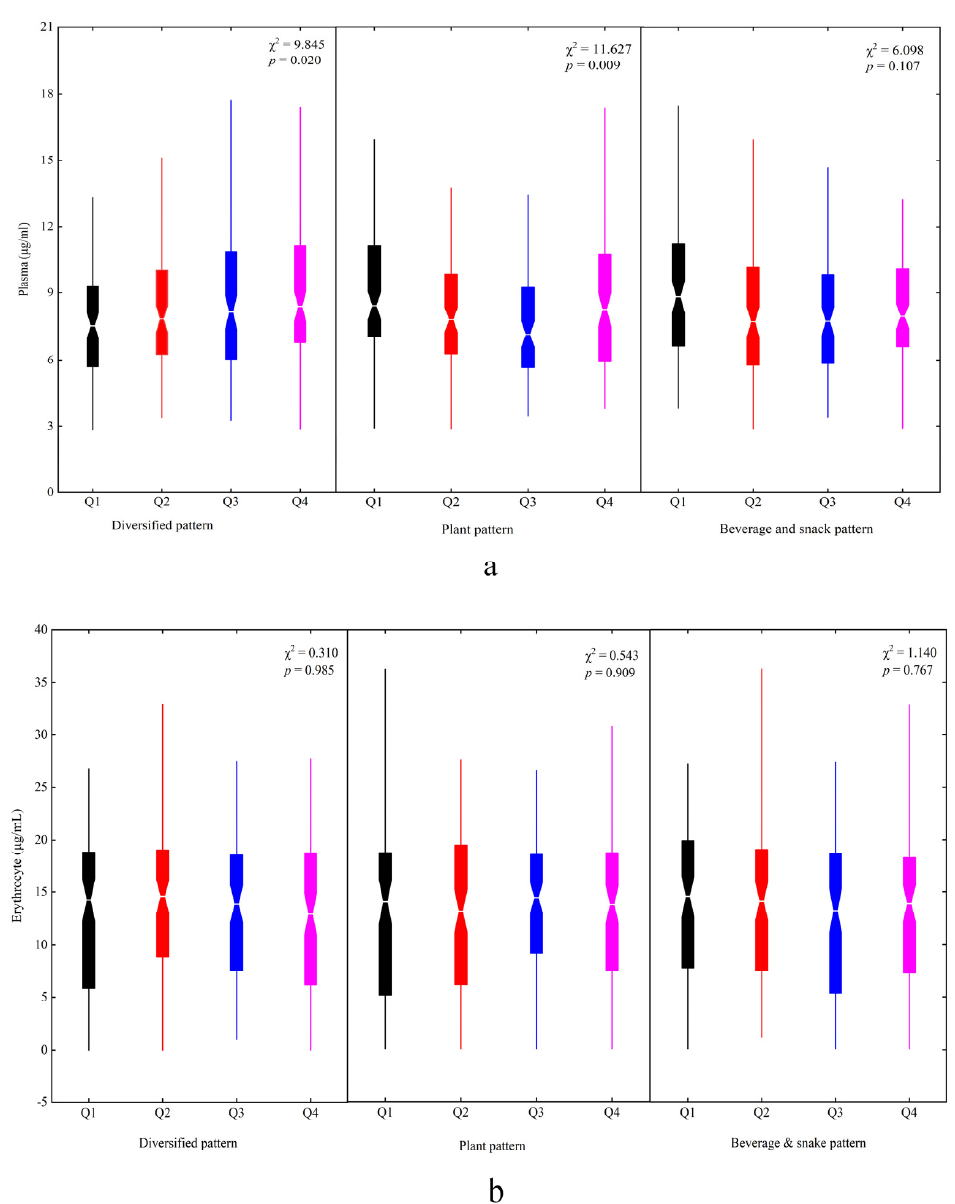
Figure 3. The plasma and erythrocyte DHA status in different dietary patterns among children: ( a ) plasma and ( b ) erythrocyte. Q1~Q4 represented four quartiles of factor scores for dietary patterns: Q1, black; Q2, red; Q3, blue; Q4, magenta.